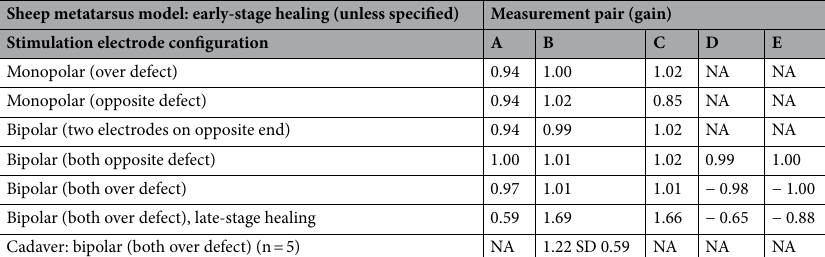
Sheep metatarsus model: early-stage healing (unless specified)